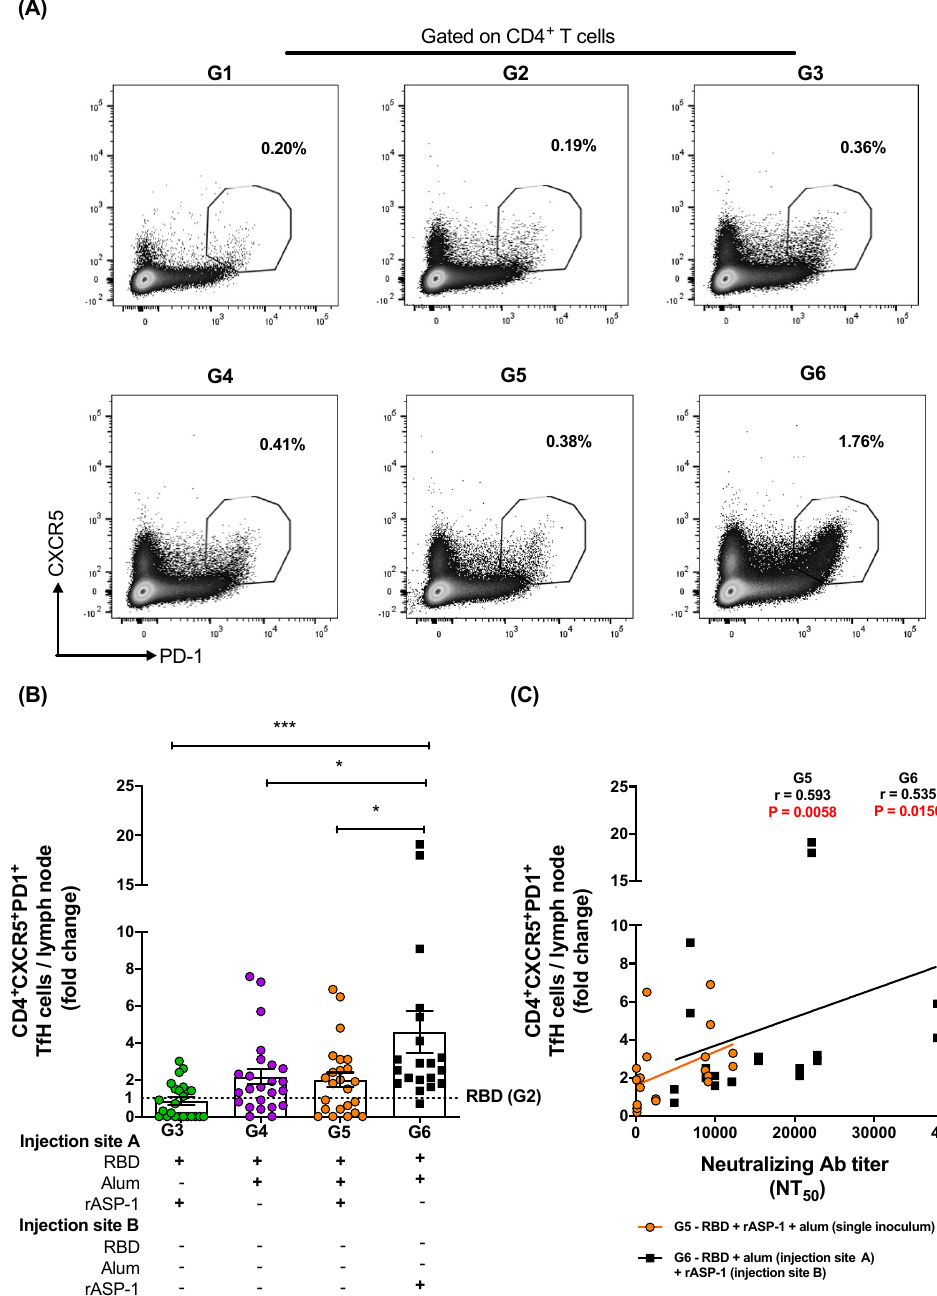
Figure 4. Fold increase in the frequency of TfH cells in the lymph nodes (LNs) of immunized mice: C57BL/6 mice were immunized i.m. with MERS-RBD-Fd with or without alum and rASP-1 alone or together using different combinations and/or formulations (Table 1 and X-axis legend). The draining LNs were harvested on day 7 post-2nd immunization and the frequency of TfH cells per LN was analyzed. (A) Representative flow cytometry plot in each immunization group. (B) The fold increase in the frequency of TfH cells per LN in all the adjuvanted-vaccine groups was normalized against the RBD vaccine group (G2). (C) The fold increase in the frequencies of TfH cells per LN from groups G5 and G6 were correlated with the NT 50 titers determined in each serum sample of the corresponding mice. The experiment was repeated at least twice with 3 to 5 mice per group and the data are represented as mean and standard error of individual LN per mice. “ + ” indicates the presence and “ − “ indicates the absence of the protein or adjuvants in the formulation. Statistics was performed using one-way ANOVA with Tukey’s multiple comparison. p < 0.05: *, p < 0.001: ***. Spearman correlation was performed to determine the association of TfH cells with neutralizing antibody